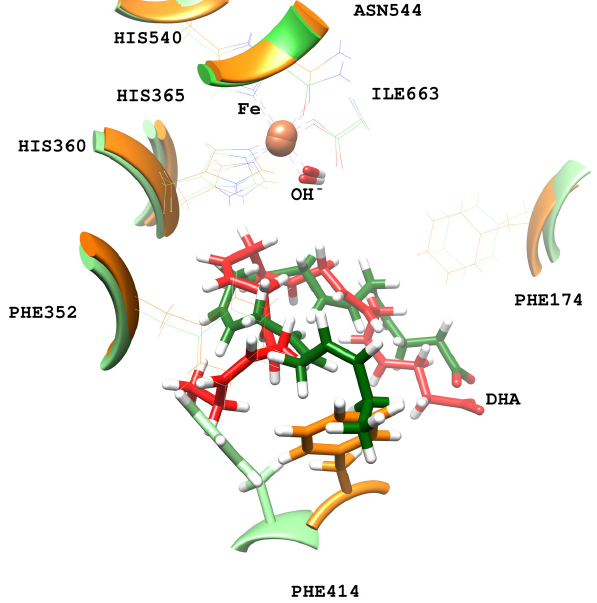
Figure 7. Main stacking interactions between hALOX12 residues and DHA. The protein residues and DHA are shown in green for the closed conformation, and in orange and red, respectively, for the open conformation of the MD replica 1.